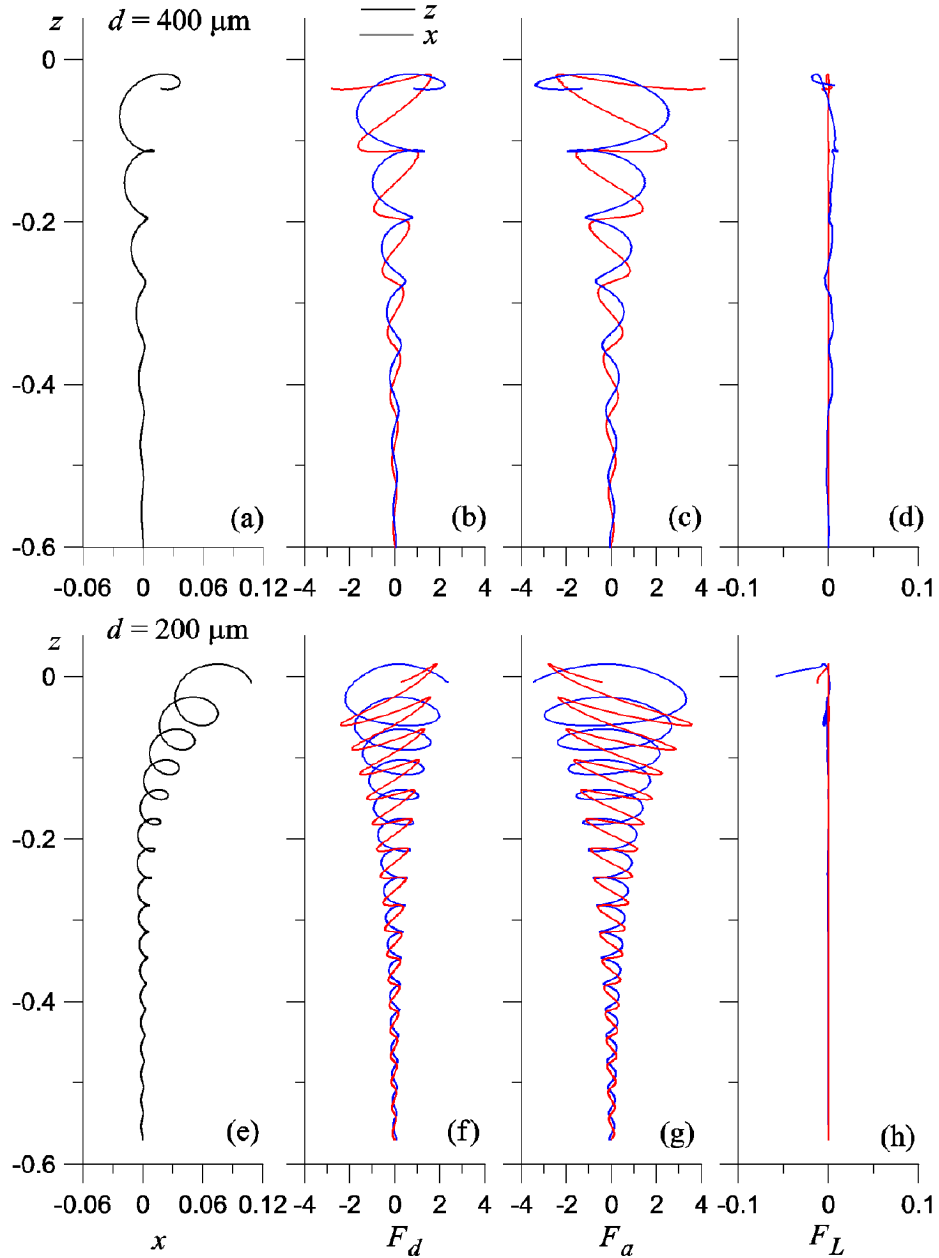
Figure 6. The same as in Figure 5 but obtained using DNS with finite U d . The analysis of forces governing bubbles dynamics reveals that the drag force, F d , and the fluid-acceleration force, F a , are both of the same order, and much larger as com- pared to the lift force, F L . The forces, F a and F d , increase monotonically as the bubbles rise toward the water surface, whereas the lift force becomes non-zero only in close vicinity of the surface, where the fluid motion is not strictly irrotational due to the presence of wave-induced turbulence [17]. The profiles of the mean bubble concentration (or void fraction), [ C ], and x and z components of the concentration fluxes, [ CV x ] and [ CV z ], were evaluated in DNS according to Equations (28) and (29) for different bubble size, and both with and without wind stress at the water surface (Figure 7). Figure 7 also compares numerical solution for the fluxes with their parameterizations in the form: